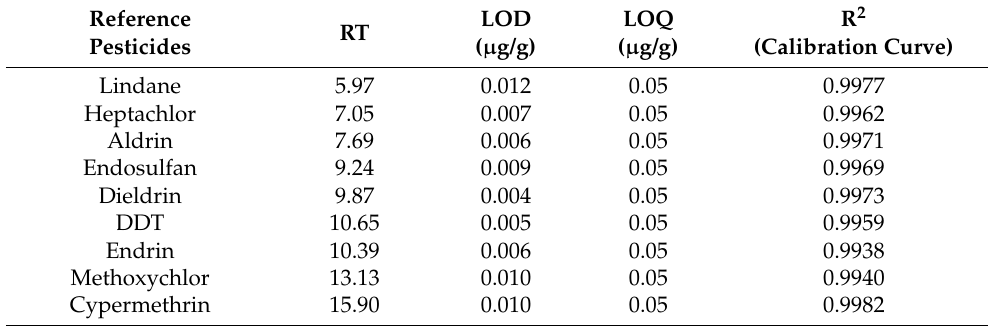
Table 2. Retention time (RT), limit of detection (LOD), limit of quantification (LOQ) and coefficient of determination (R 2 ) of the selected reference pesticides in the fish matrix at different fortification